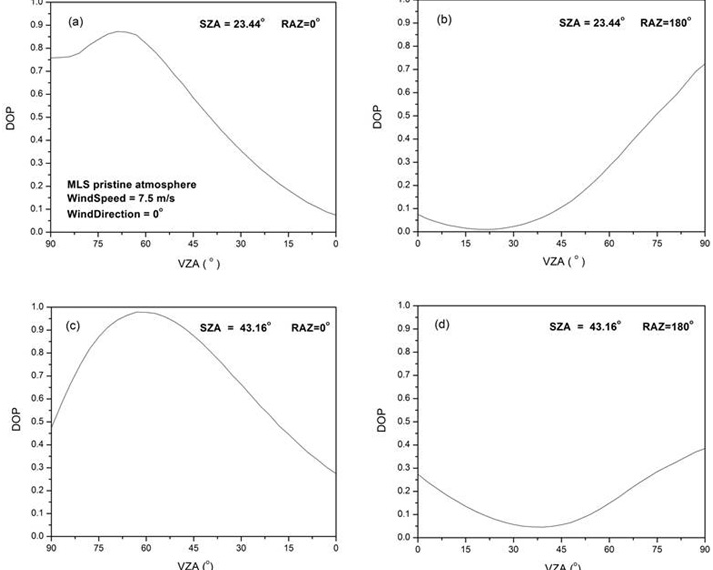
Fig. 5. Same as in Fig. 4, but for the DOP on the principal plane from the ADRTM. The solar zenith angle (SZA) for (a) and (b) is 23.44 ◦ and for (c) and (d) is 43.16 ◦